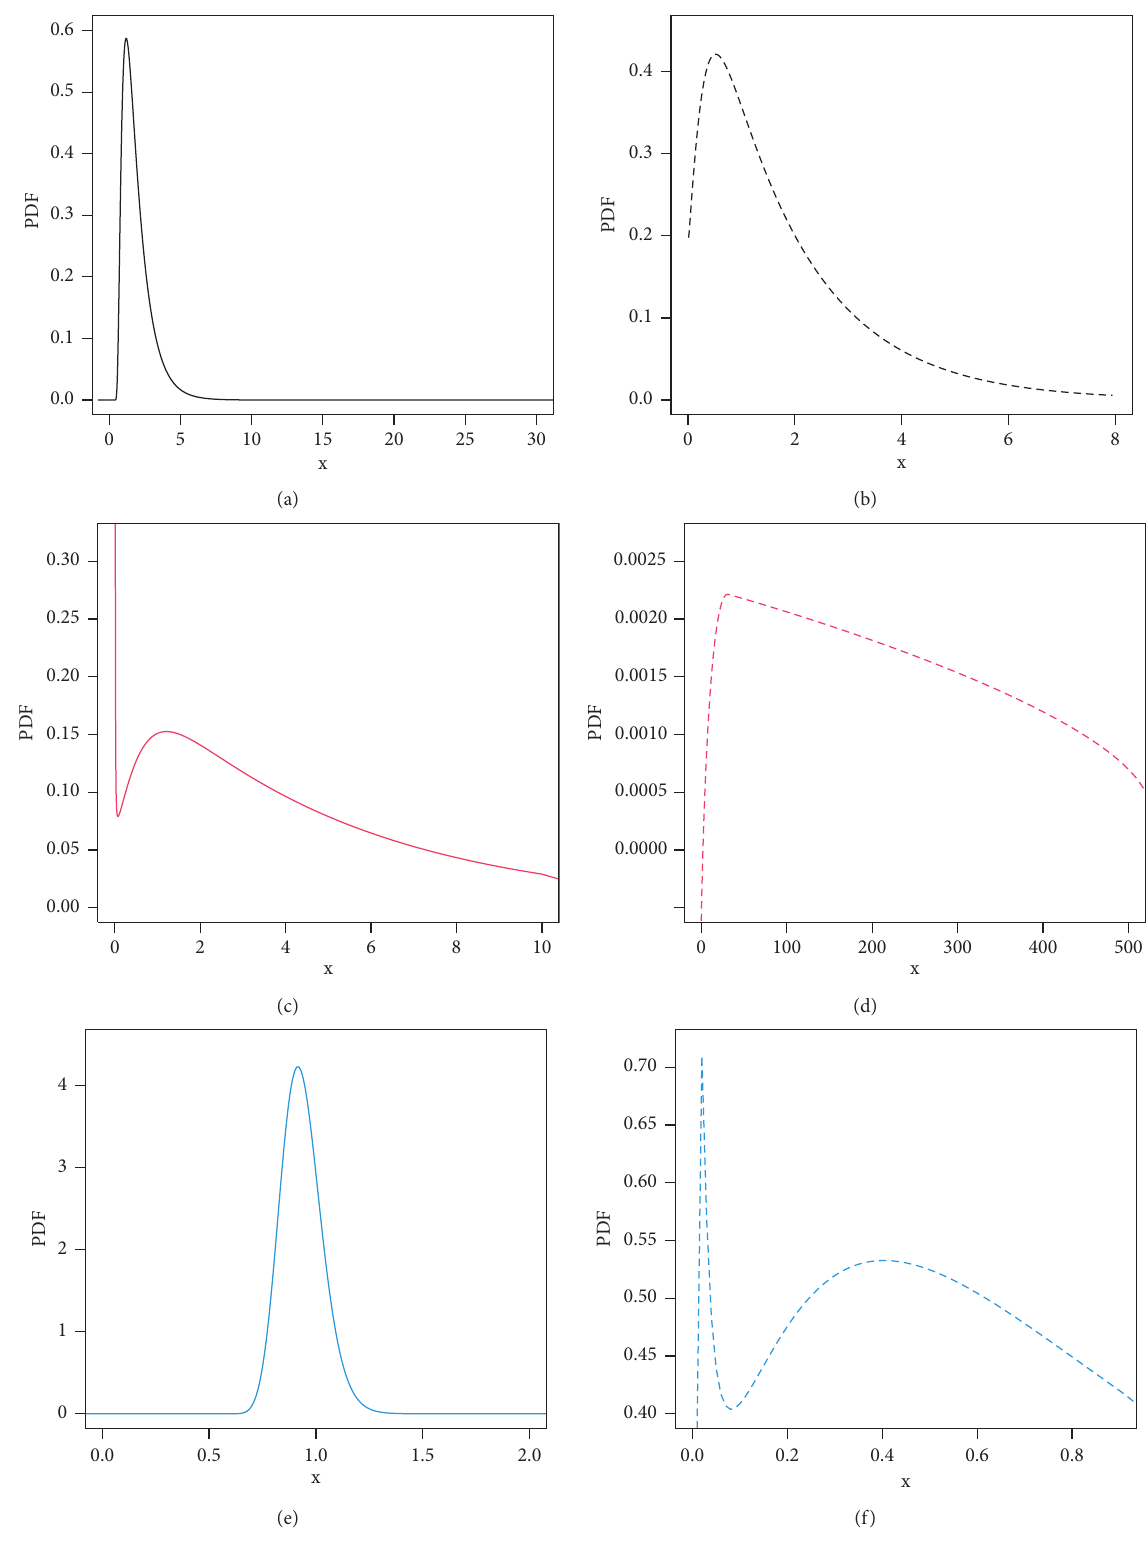
Figure 1: PDF plots of the TIITLIFW model for some different values of the parameters. (a) α � 1 , θ � 1 , λ � 1. (b) α � 0 . 0001 , θ � 4 , λ � 0 . 15. (c) α � 0 . 0001 , θ � 2 , λ � 0 . 1. (d) α � 5 , θ � 0 . 05 , λ � 0 . 05. (e) α � 2 , θ � 2 , λ � 10. (f) α � 0 . 1 , θ � 5 , λ � 0 .